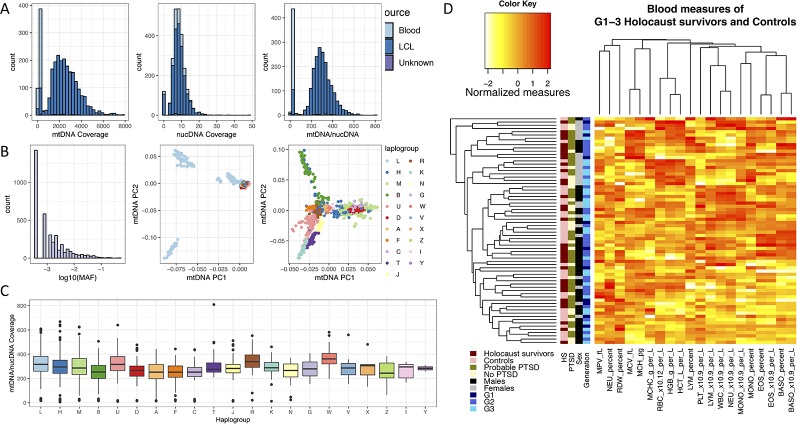
Effects of mtDNA haplogroup and blood cell count on mtDNA copy number measurements. (A) Left and middle panel show the sequencing coverage over mtDNA and nuclear DNA in Blood (light blue) and lymphoblastic cell lines (LCL, blue) in the 1000 Genomes Phase 3 project, and the right panel shows the ratio between them. (B) The left panel shows the number of SNP variants called per minor allele frequency (MAF) on the log10 scale from sequencing of mtDNA in LCL samples of 1000 Genomes Phase 3 individuals; the middle panel shows the distribution of all individuals by their first two principle components computed from mtDNA SNPs (mtDNA PC1, mtDNA PC2), colored by their mitochondrial haplogroups. Individuals of Haplogroup L (mostly of African origin) contribute the greatest mtDNA diversity as shown in the middle panel, and removing these individuals from the principle component analysis gives greater resolution for visualization of the mtDNA diversity among all other Haplogroups, as shown in the right panel. (C) Boxplot of effect of mtDNA Haplogroups on mtDNA copy number, estimated using the ratio of mtDNA and nuclear DNA sequencing coverage. All Haplogroups with significant effects on mtDNA copy number (L, A, B, C, D, F) are rare in European populations. (D) Heatmap and clustering of normalized blood cell count measures obtained from 70 individuals in this study.